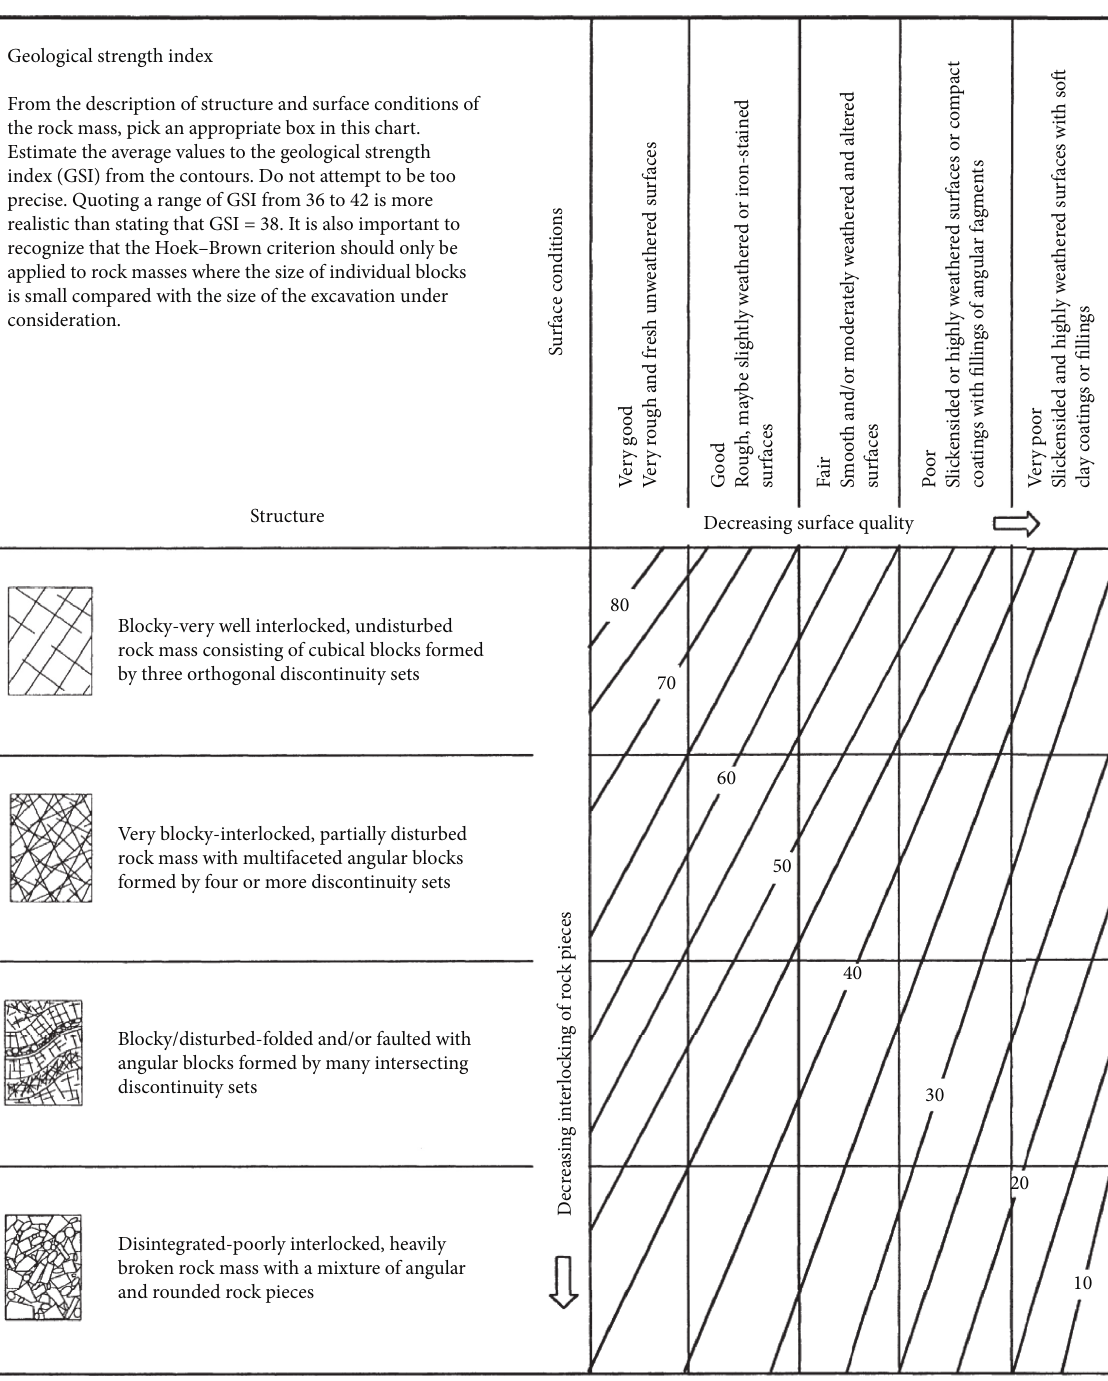
Figure 2: GSI basic chart [43, 61,